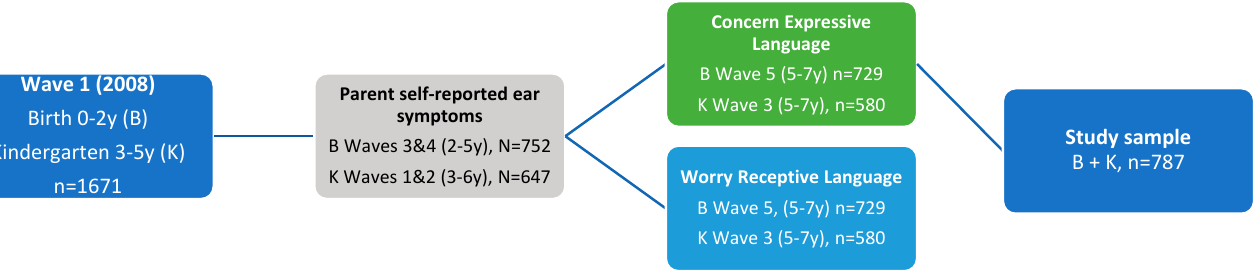
Figure 1. Flow chart of study participants within Footprints in Time: Longitudinal Study of Indige- nous Children.